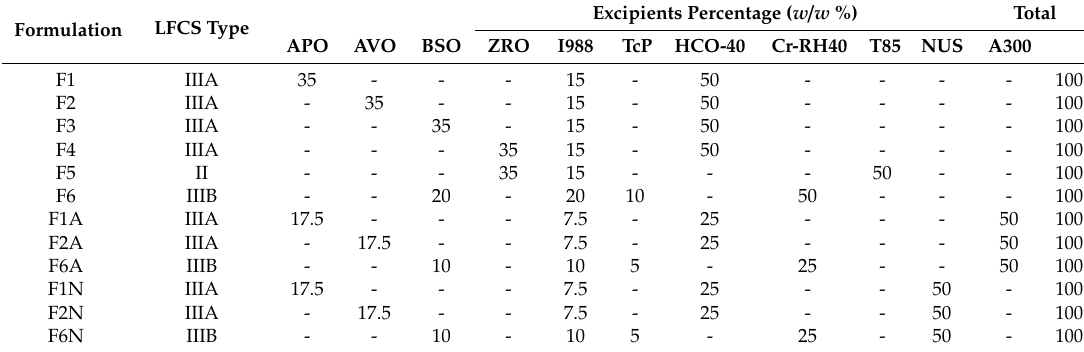
Table 6. The compositions of lipid-based